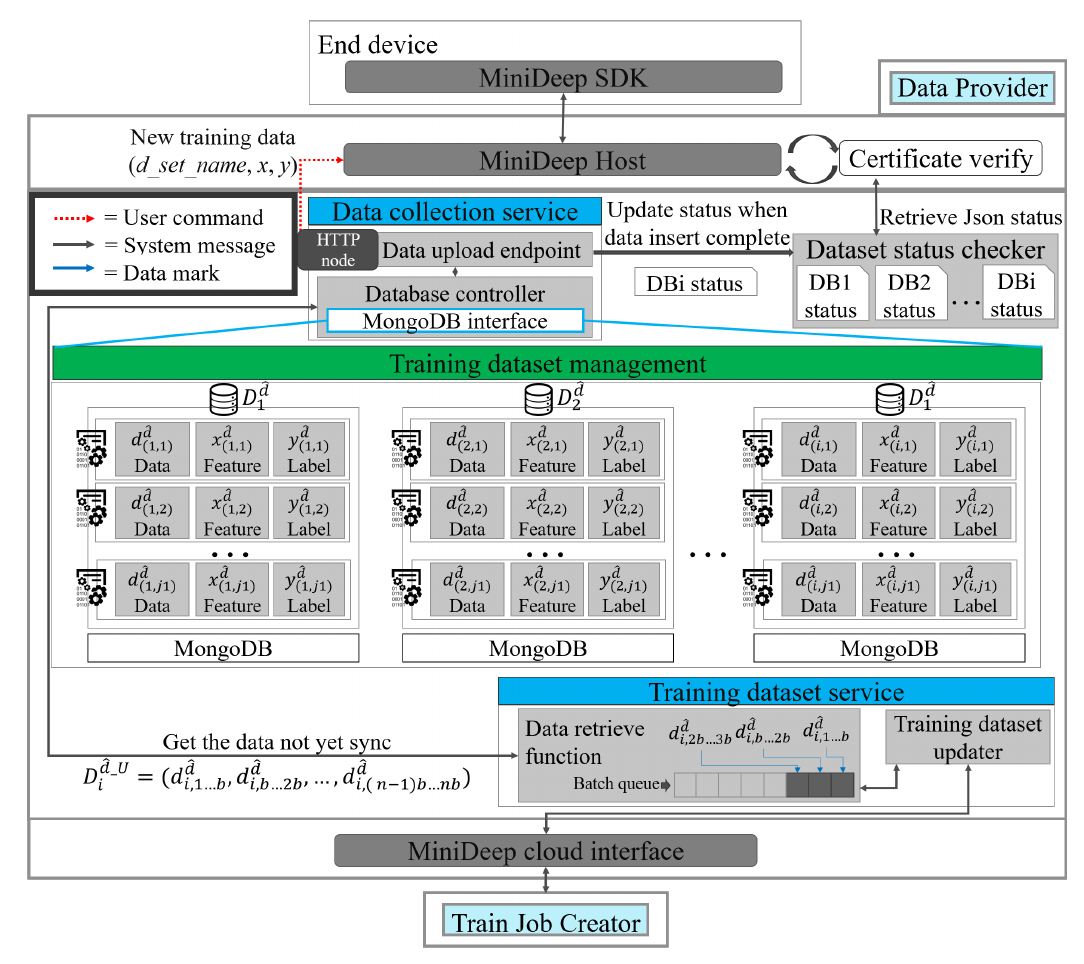
Figure 3. The detailed functions of the Data Provider